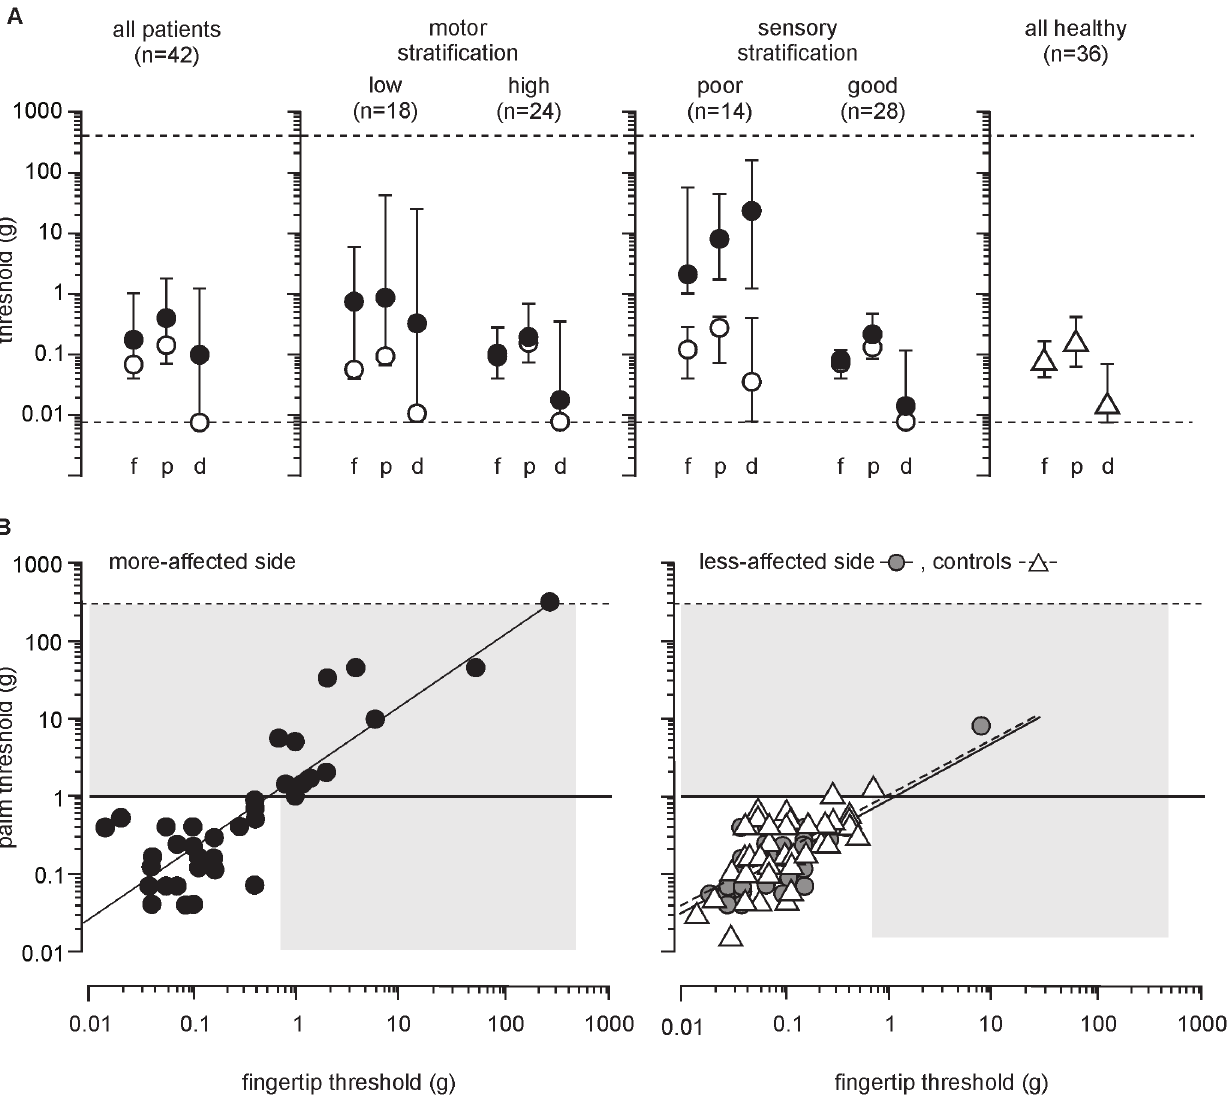
Figure 2. Cutaneous sensation after stroke and in age- and sex-matched healthy subjects A) Cutaneous sensation according to classification. Higher numbers represent poorer sensation (higher thresholds), data presented as median and interquartile range on a logarithmic scale (log 10 ). Dashed lines indicate minimum and maximum monofilament size (0.008–300 g). Open circles: less-affected side; filled circles: more- affected side. Open triangles: healthy subjects, combined hands. Regions: f: fingertip; p: palm; and d: dorsum. B)Correlationbetweenfingertipand palmthresholds. The zone of impaired sensation is indicated by grey shading (fingertip 0.6 g, palm 1.0 g, see text for details). The left hand panel illustrates a significant positive correlation between the fingertips and palm thresholds for the more-affected side (r s (40)=0.79, p , 0.001); the right hand panel illustrates the correlations for the less-affected side (r s (40)=0.58, p , 0.001), and healthy subjects (r s (34)=0.64, p , 0.001). r s =correlation co-efficient (degrees of freedom).